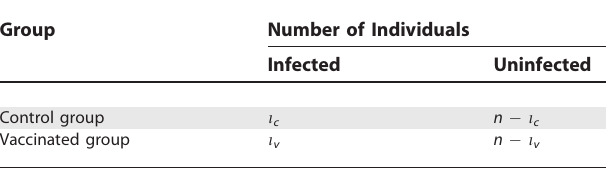
Table 1. Contingency Table of a Single Low-Dose Challenge